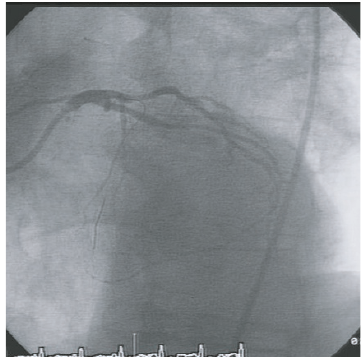
Figure 8: A typical frame from an angiography